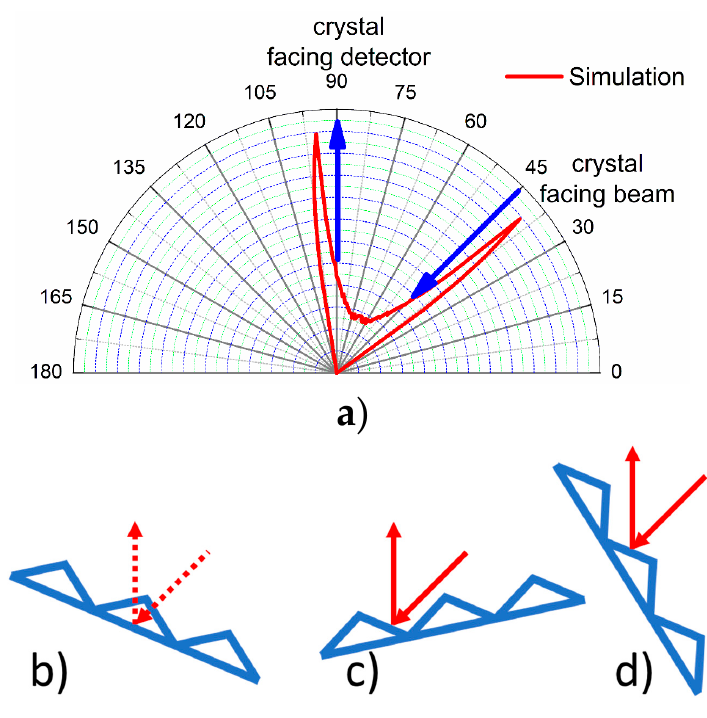
Figure 2. ( a ) Simulated signal intensity of a scattering simulation for Pt{110}-(1 × 2). Pictograms of the {110} crystal orientation at key specular positions: ( b ) pseudo-specular reflection from the surface plane ignoring microfacets; ( c ) specular reflection from first facet ~102 ◦ ; and ( d ) specular reflection from second facet at ~33 ◦ .